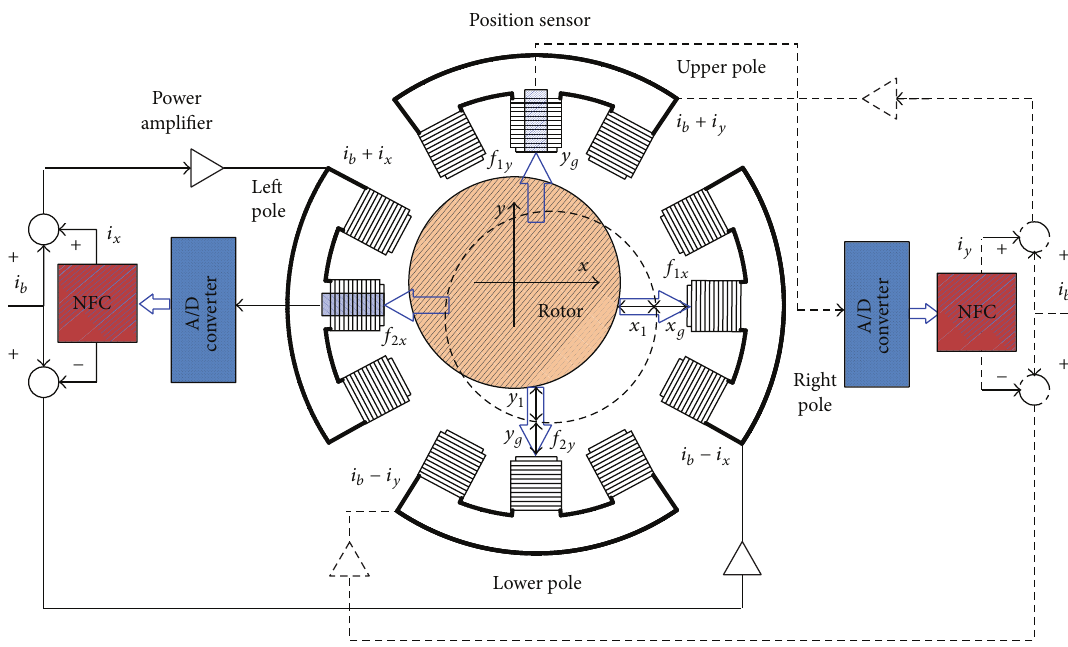
Figure 2: Drive system of an AMB.